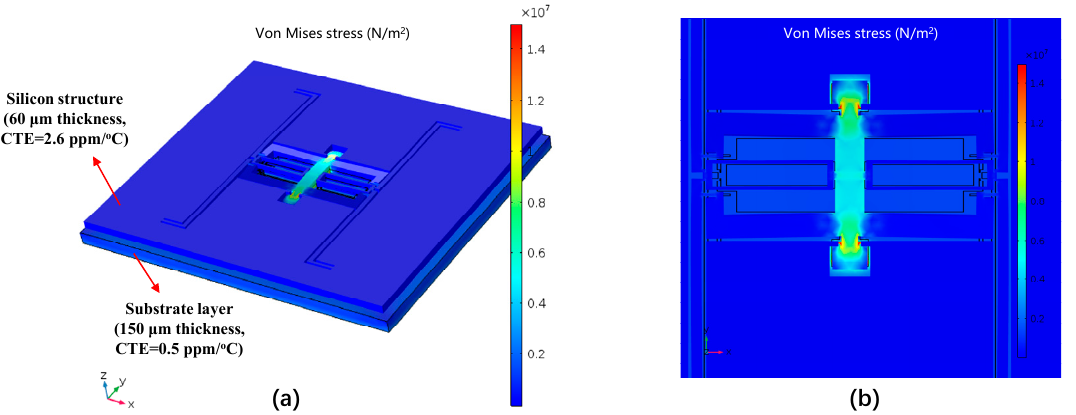
Figure 6. Simulated Von mises stress nephogram of the SRA. ( a ) The thermal stress distribution when the ambient temperature rises from the room temperature to +50 °C; ( b ) Detailed view of the stress distribution on the anchors and isolation frame.